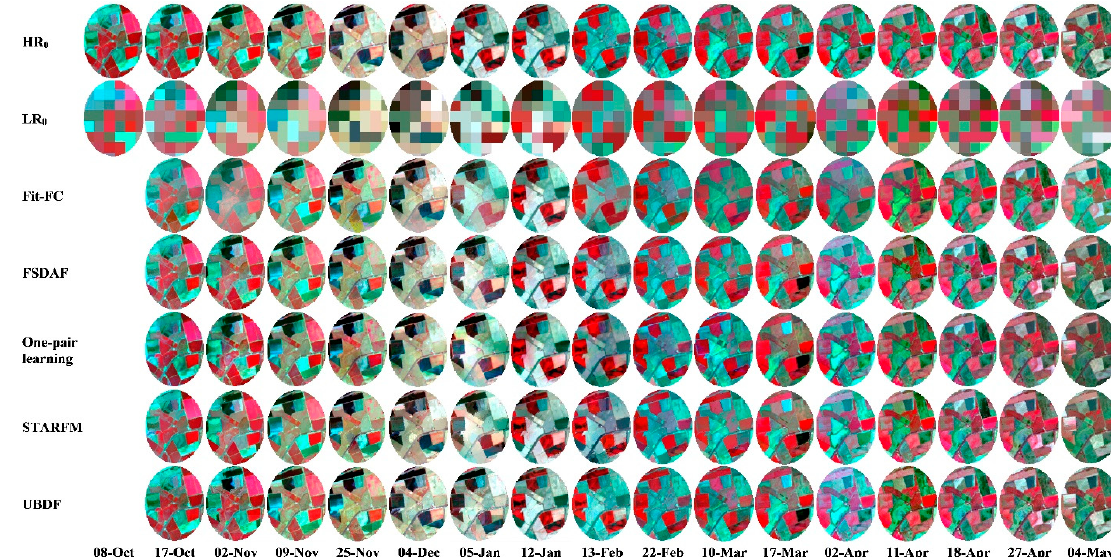
Figure A1. Observed Landsat data and simulated Landsat-like images with the fusion method indicated above for the subregion A of Coleambally in Figure 2. All images are displayed in chronological order from 2001 to 2002 (NIR, red and green as RGB).